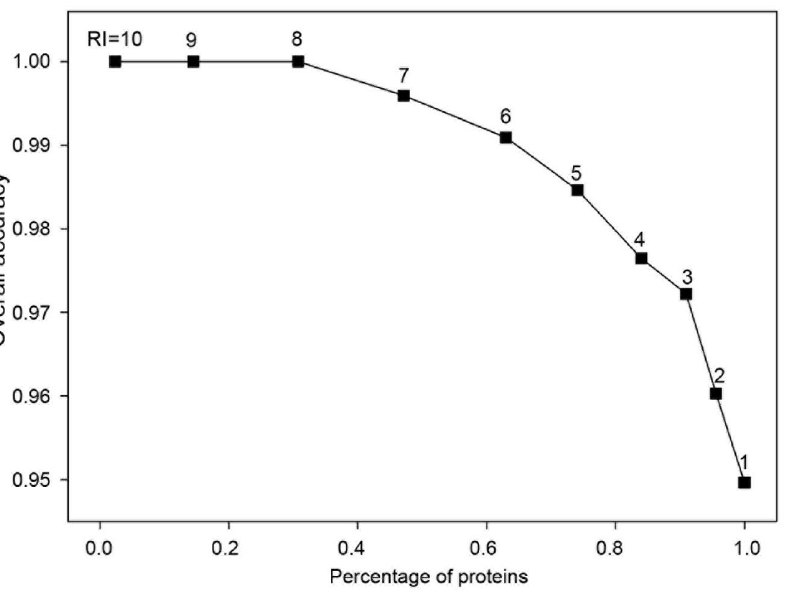
Figure 2. The average prediction accuracy calculated cumulatively with RI above a given value. This result was obtained using RF with a 20-fold cross validation.